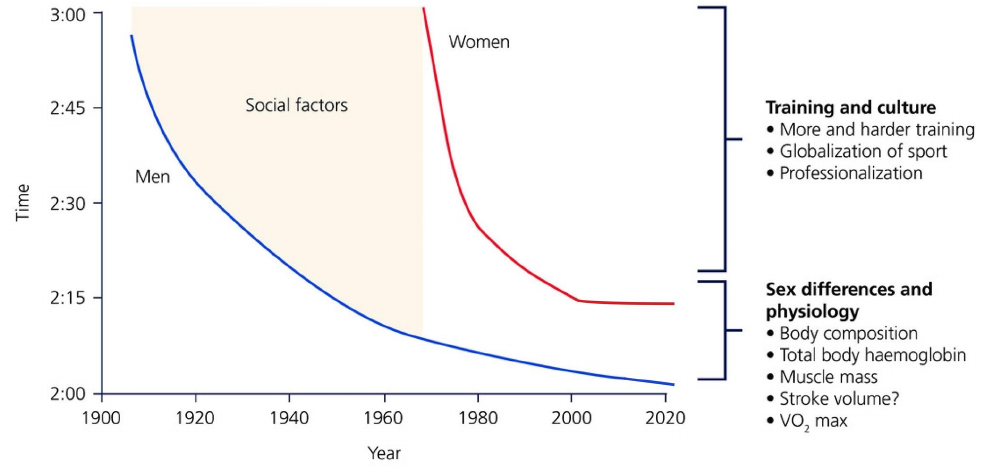
Figure 1. Reprinted with permission from Ref. [3]. 2017 The Physiological Society. History of world records in the marathon for men and women, modified slightly to show current world record times. marathon record times through 2005. Physiological sex differences are primarily responsible for the gap that still exists between men’s and women’s times in all distances of individual endurance